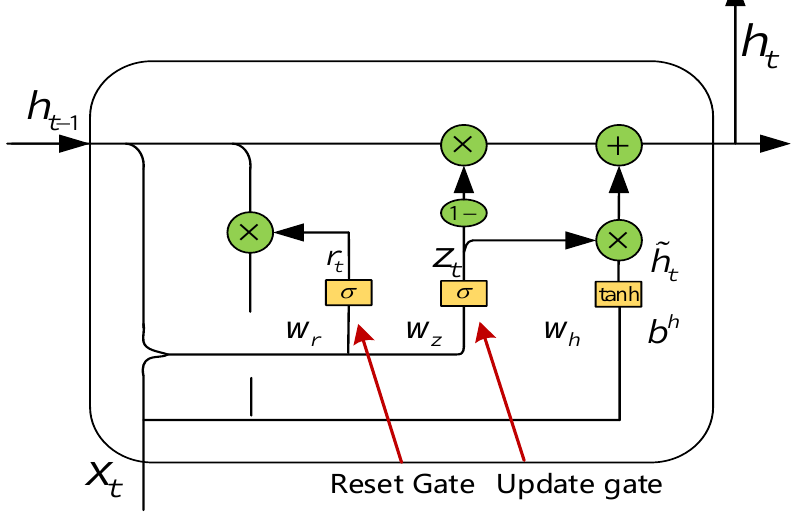
Figure 8. GRU structure diagram.